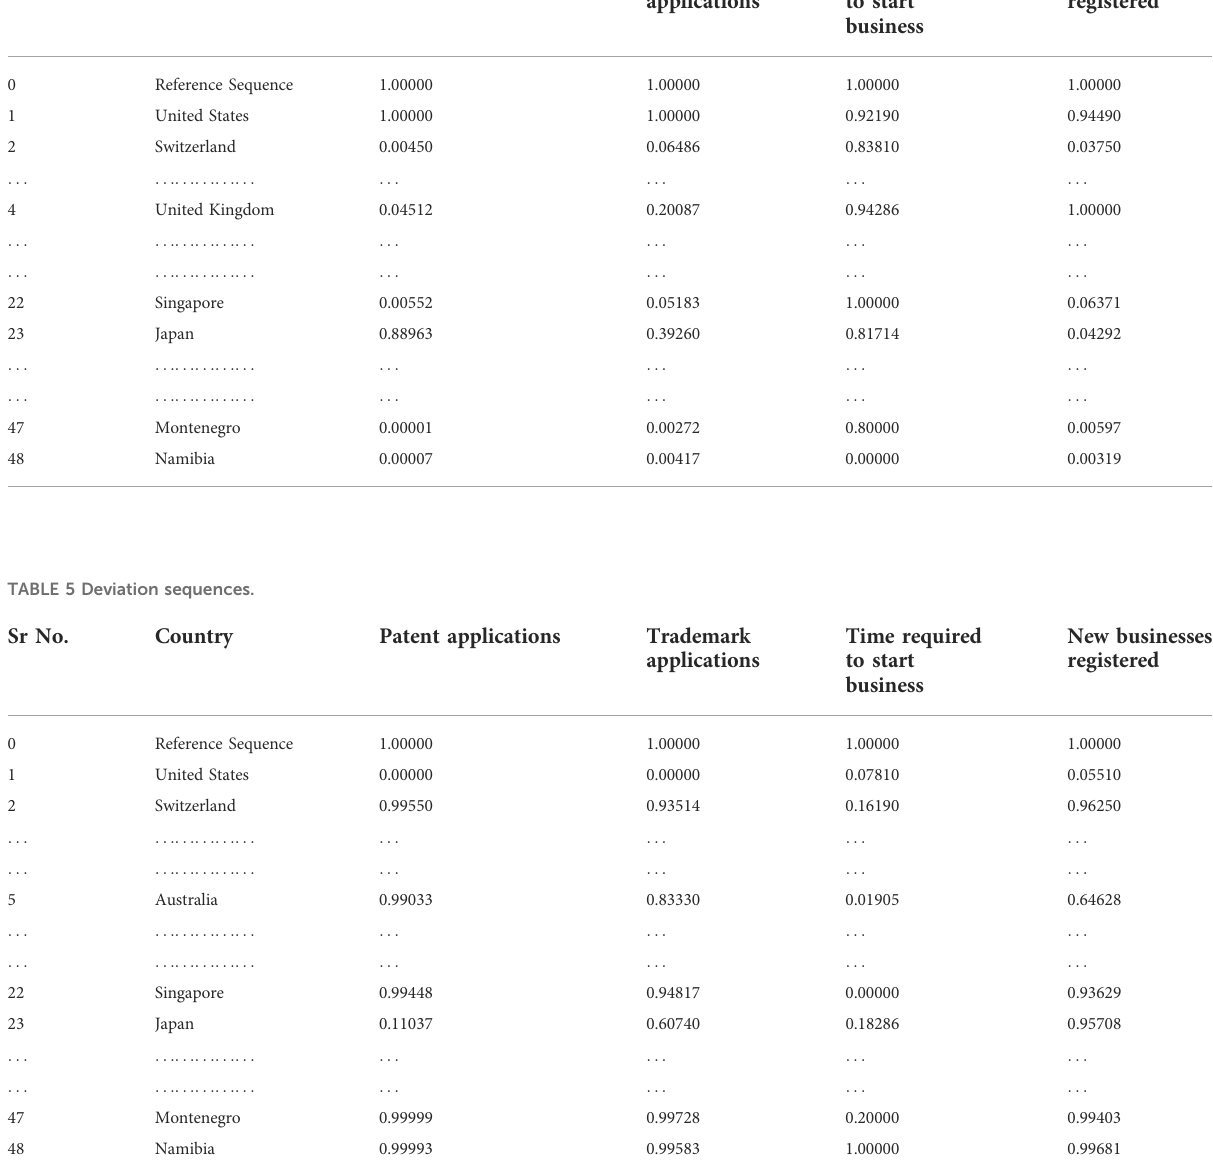
reference series, 4) calculation of deviation sequence, 5) calculation of grey relational coef fi cients, 6) calculation of grey relational grades, and 7) generation of ranking list. As an augmentation of GRA, a classi fi cation based on grey relational grades is also introduced (Qazi et al., 2021a). Although we have adopted algorithm of GRA from Ertu ğ rul et al. (2016), it is still found to be bene fi cial to reiterate the algorithm (Annex 1).